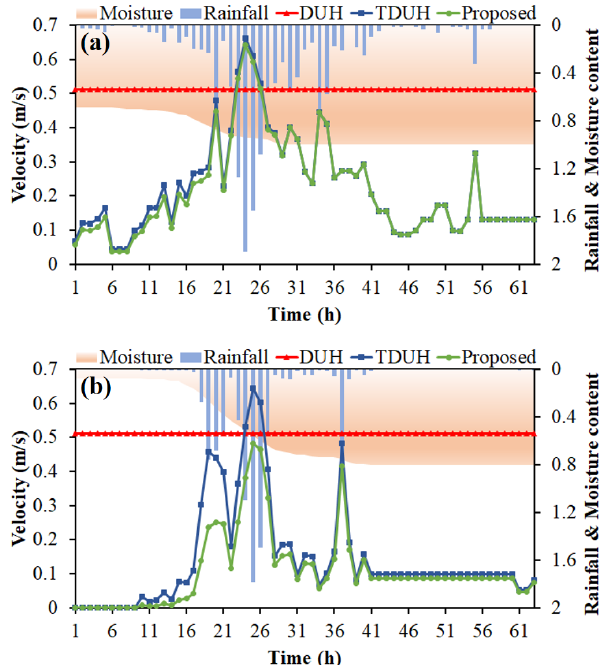
Figure 15. Time-varying velocity values of a grid cell in different storm events. (a) Time-varying velocity in storm event no. 20130817. (b) Time-varying velocity in storm event no. 20150709. The rainfall content is I s , and the soil moisture con- tent is θ s